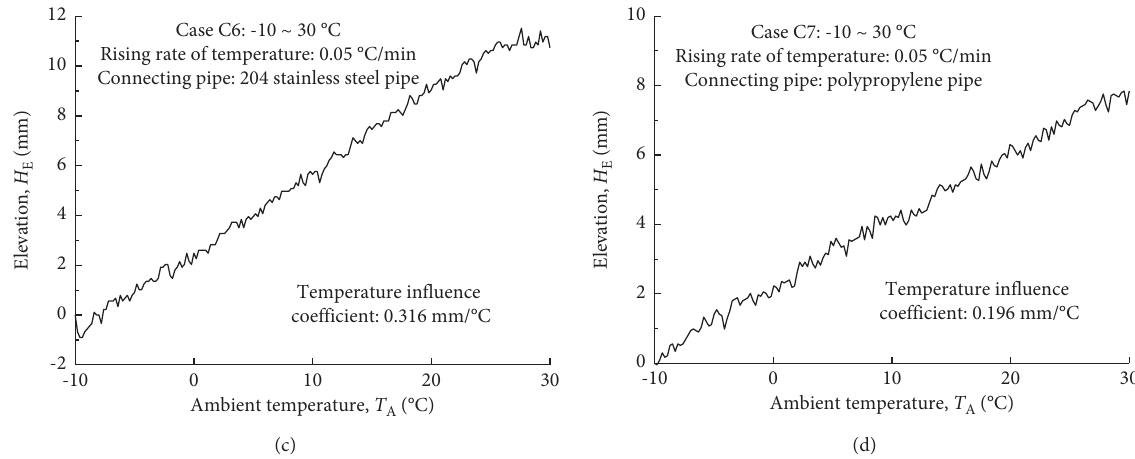
Figure 5: The influence of pipe expansion coefficient on the measurement accuracy of the single HSL test point. (a) PU plastic pipe. (b) PTFE pipe. (c) 204 stainless steel pipe. (d) Polypropylene pipe.